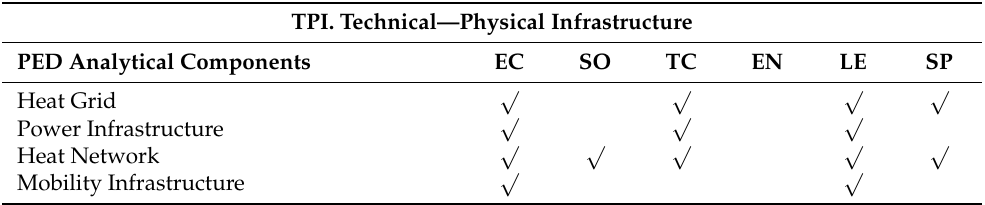
Table 11. Criteria considered for Virtual infrastructure PED analytical components analysis. TPI. Technical—Physical Infrastructure